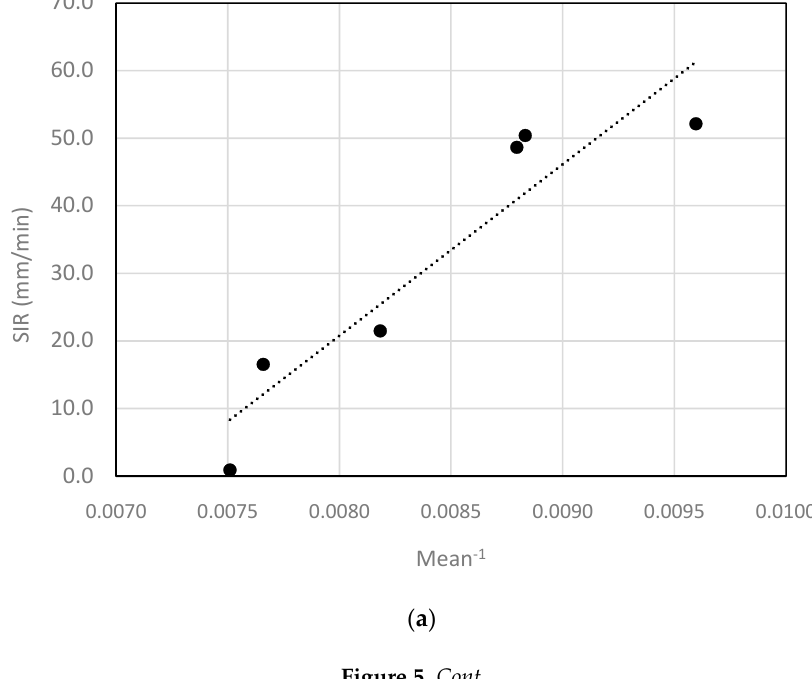
Figure 4. Histogram of the gray levels produced for each image for ( a ) locations 1 to 3, and ( b ) locations 4 and 5 and the Sample, of porous asphalt as a normalized pixel count for each gray level. The number beside PA refers to the location on the porous strip.